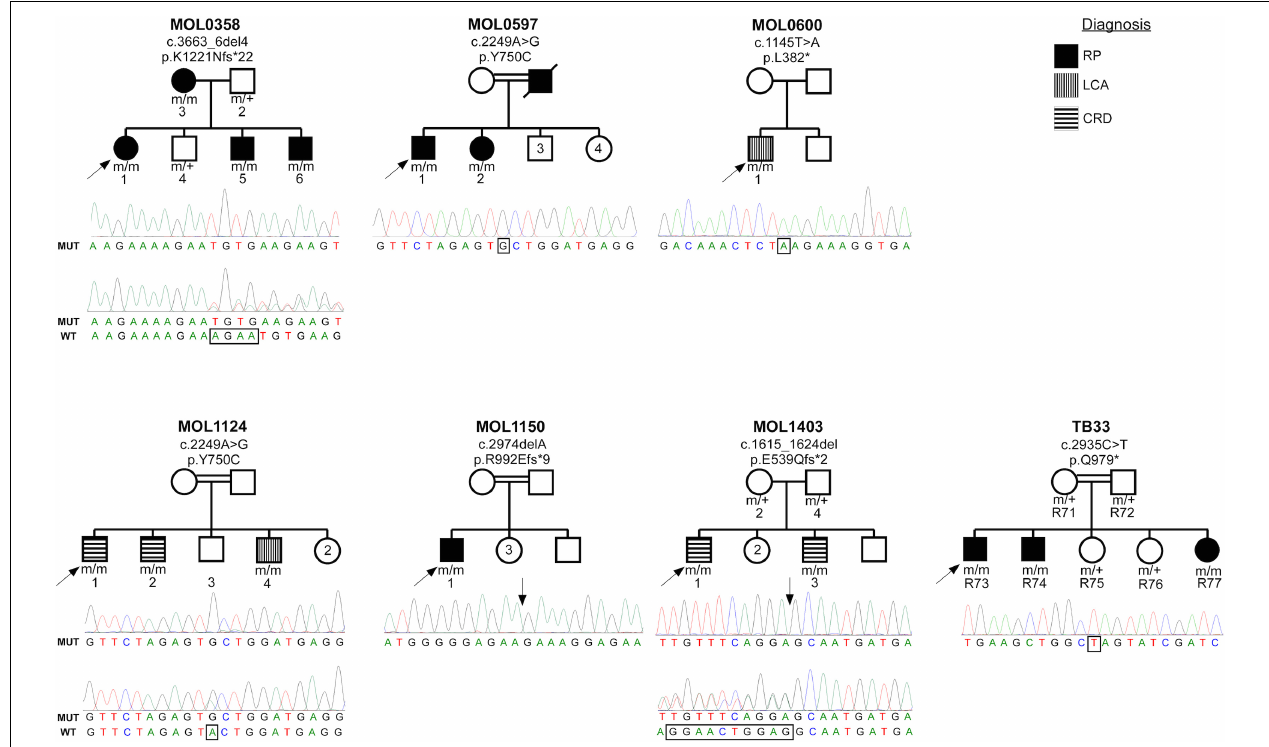
FIGURE 1 | Pedigrees of the seven families with RPGRIP1 mutations in the Israeli cohort. Family number and the causative mutation (at the cDNA and protein levels) are noted above each pedigree. The number of each subject is listed below each symbol. Shapes marked in black denote an RP phenotype, horizontal stripes indicate a CRD phenotype, and the two individuals with a LCA phenotype are denoted by vertical stripes. White shapes indicate healthy family members. Index cases are marked with black arrows. Underneath each pedigree, a chromatogram of the mutated allele (and when available of a heterozygous allele) is presented. The exact locations of the mutations are marked with rectangles and arrows.